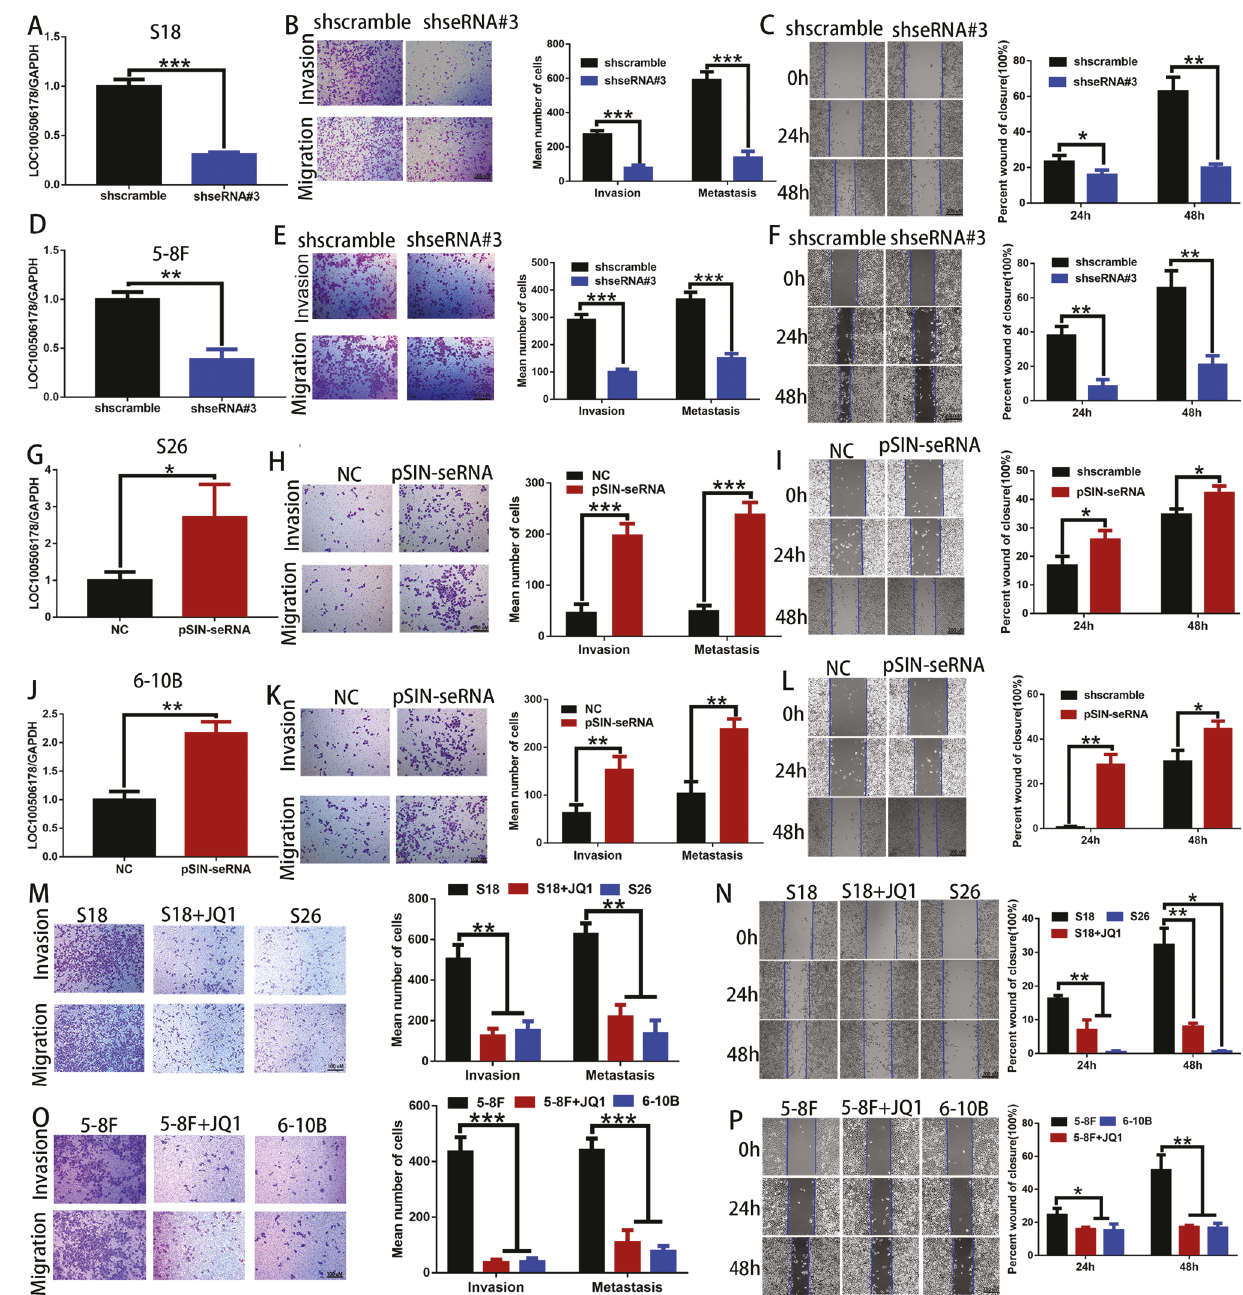
Fig. 4 seRNA LOC100506178 promoted NPC progression in vitro. A , D RT-qPCR validated that the knockdown ef fi ciencies of seRNA LOC100506178 in S18 and 5 – 8 F cells were 68.9% and 61.5%, respectively. B , E Transwell migration and invasion assays were used to detect the migratory and invasive capabilities of S18- and 5-8F-shseRNA#3 cells in the absence and presence of Matrigel, respectively; the number of migrated and invaded cells were presented as the means ± S.E.M. C , F A wound-healing assay was used to detect the migratory capabilities of S18- and 5-8F-shseRNA#3 cells, the percent wound of closure was presented as the means ± S.E.M. G , J RT-qPCR validated that the overexpression ef fi ciencies of seRNA LOC100506178 in S26 and 6-10B cells were 2.72- and 2.17-fold, respectively. H , K Transwell migration and invasion assays were used to detect the migratory and invasive capabilities of S26- and 6-10B-pSIN-seRNA cells in the absence and presence of Matrigel, respectively, the migrated and invaded cells were presented as the means ± S.E.M. I , L A wound-healing assay was used to detect the migratory capabilities of S26- and 6-10B-pSIN-seRNA cells, the percent wound of closure was presented as the means ± S.E.M. M , O Transwell migration and invasion assays were used to detect the migratory and invasive capabilities of S18 and 5 – 8 F cells after treatment with JQ1 in the absence and presence of Matrigel, respectively; the number of migrated and invaded cells were presented as the means ± S.E.M. N , P A wound-healing assay was used to detect the migratory capabilities of S18 and 5 – 8 F cells after treatment with JQ1, the percent wound of closure was presented as the means ± S.E.M. NC negative control, *** P < 0.001; ** P < 0.01; * P <